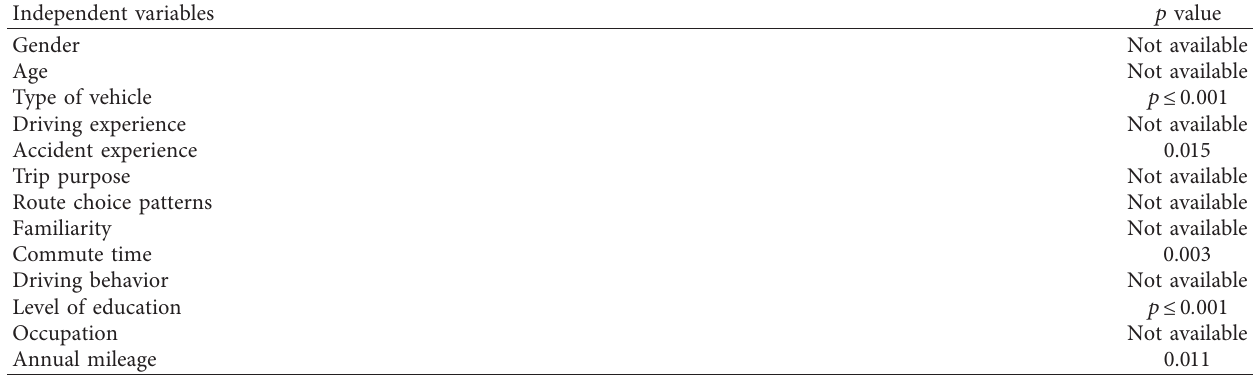
Table 3: Results of the chi-square test.